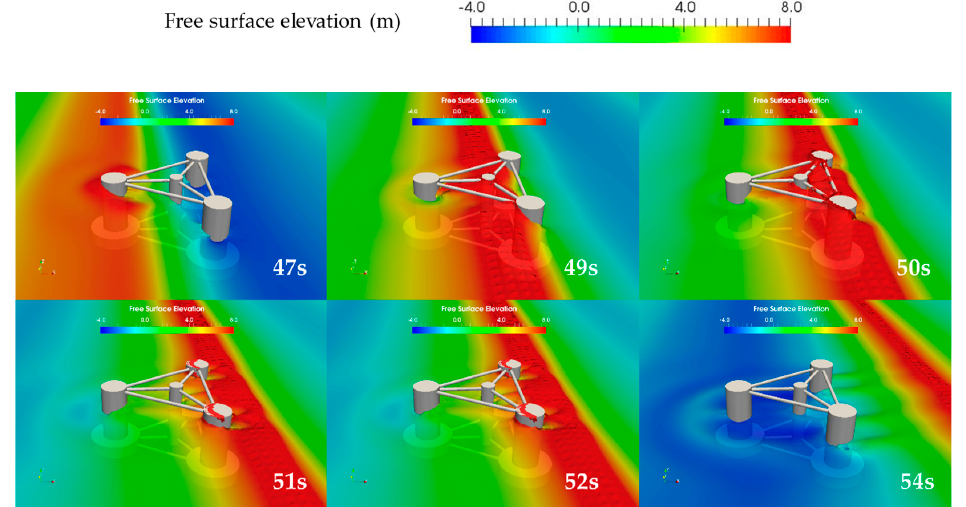
Figure 16. Wave elevation contour plots around a fixed semi-submersible platform under focused wave ( H s = 14.7 m T p = 15.0 s).